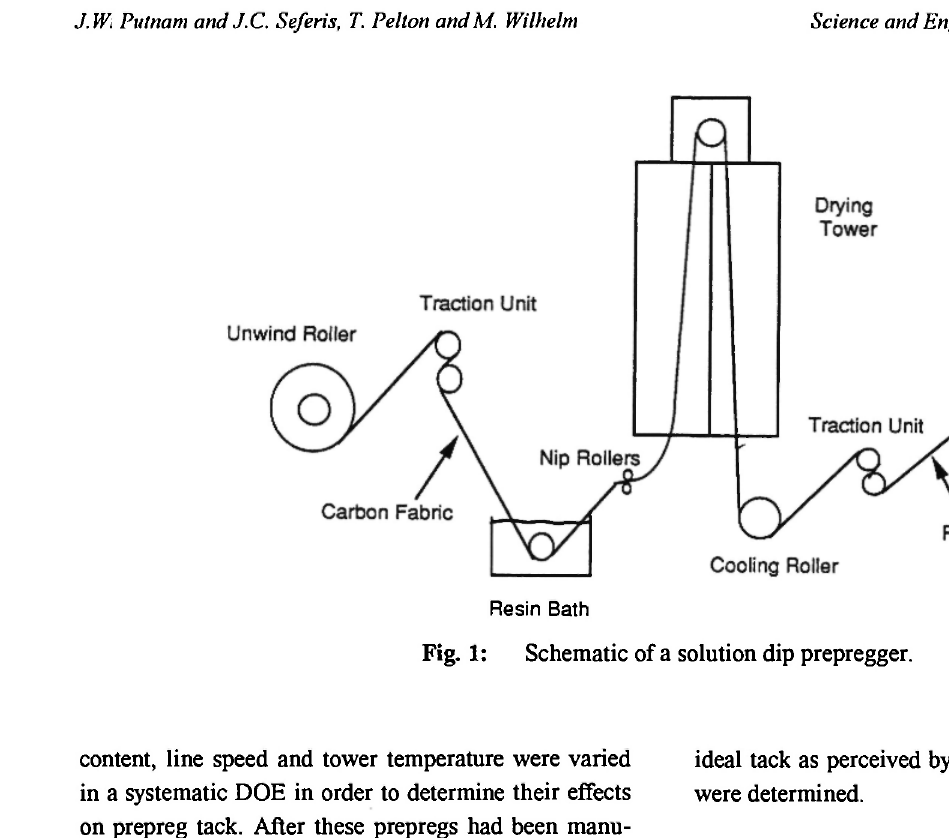
Fig. 1: Schematic of a solution dip prepregger.